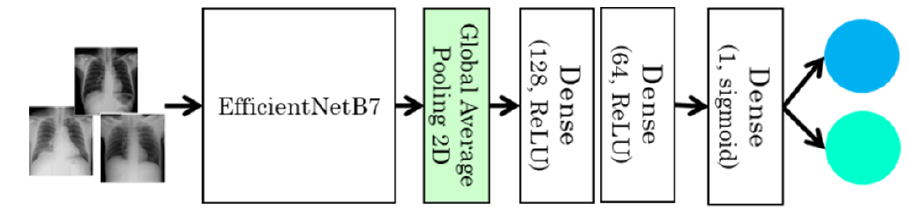
Figure 4. Deep Learning model for the chest X-ray (case 2).